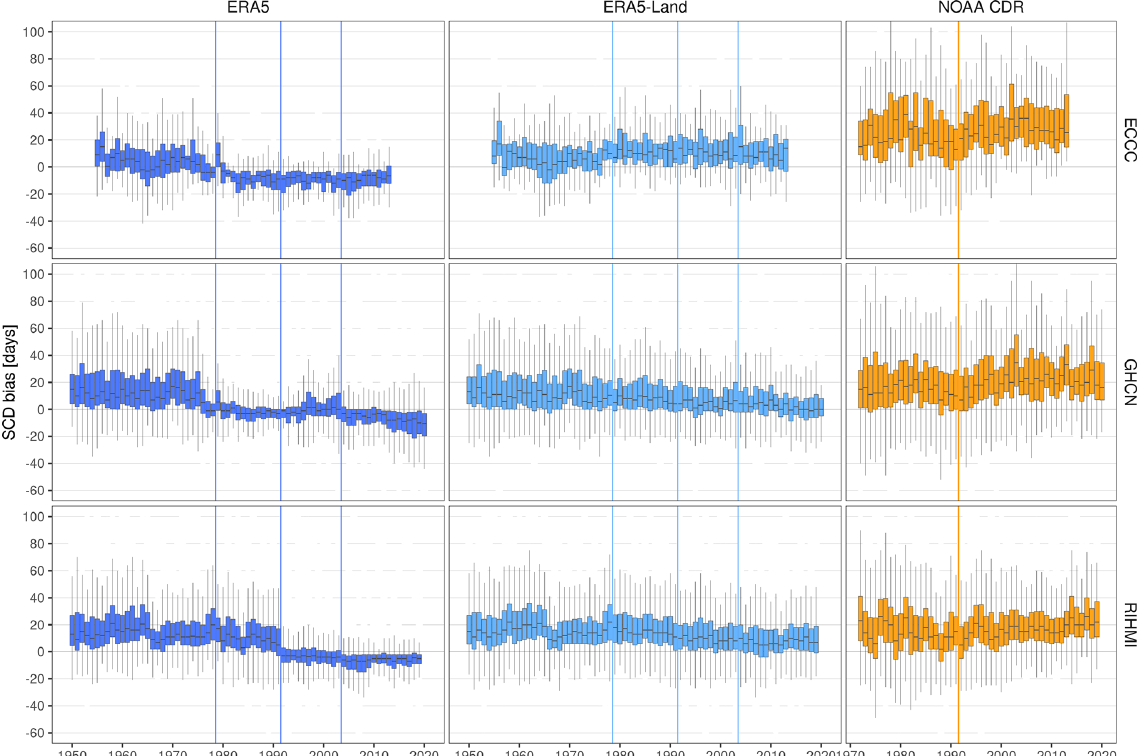
Figure 5. Temporal evolution of the annual bias (product – station) in snow cover duration (SCD) per network. Vertical lines show the years when the potential discontinuities/trends in each product